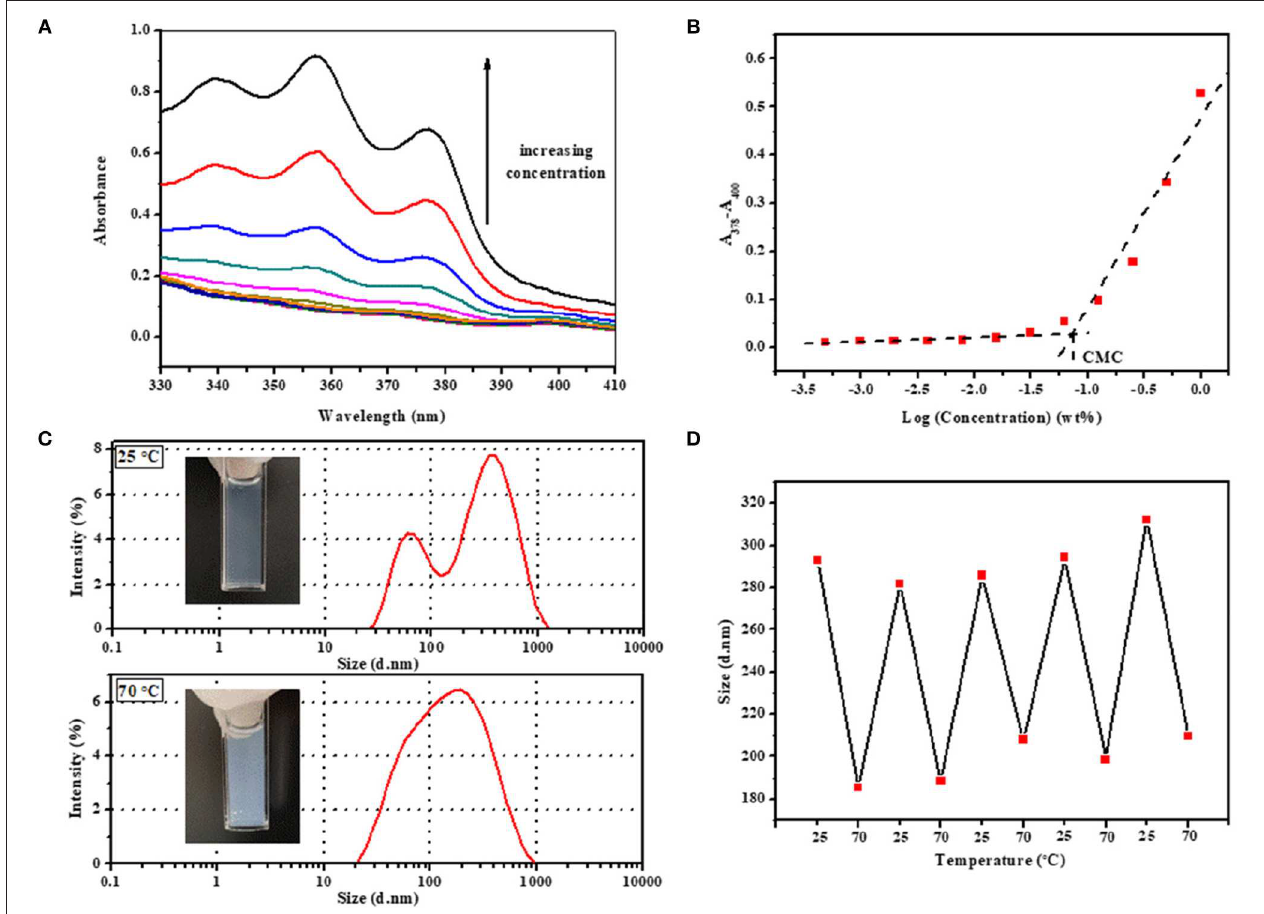
FIGURE 3 | (A) UV–vis spectra of aqueous copolymer solution with concentration ranging from 0.005 to 10 mg · mL − 1 at 25 ◦ C and (B) CMC determination for 2PDEP. (C) Real images and hydrodynamic diameter distribution by intensity of micelles at 25 and 70 ◦ C and (D) reversible transition in mean hydrodynamic diameter distribution of micelles between 25 and 70 ◦ C for 2PDEP aqueous solution with concentration of 1 mg · mL − 1 . diameter and PDI of the micelles are 293.1 nm and